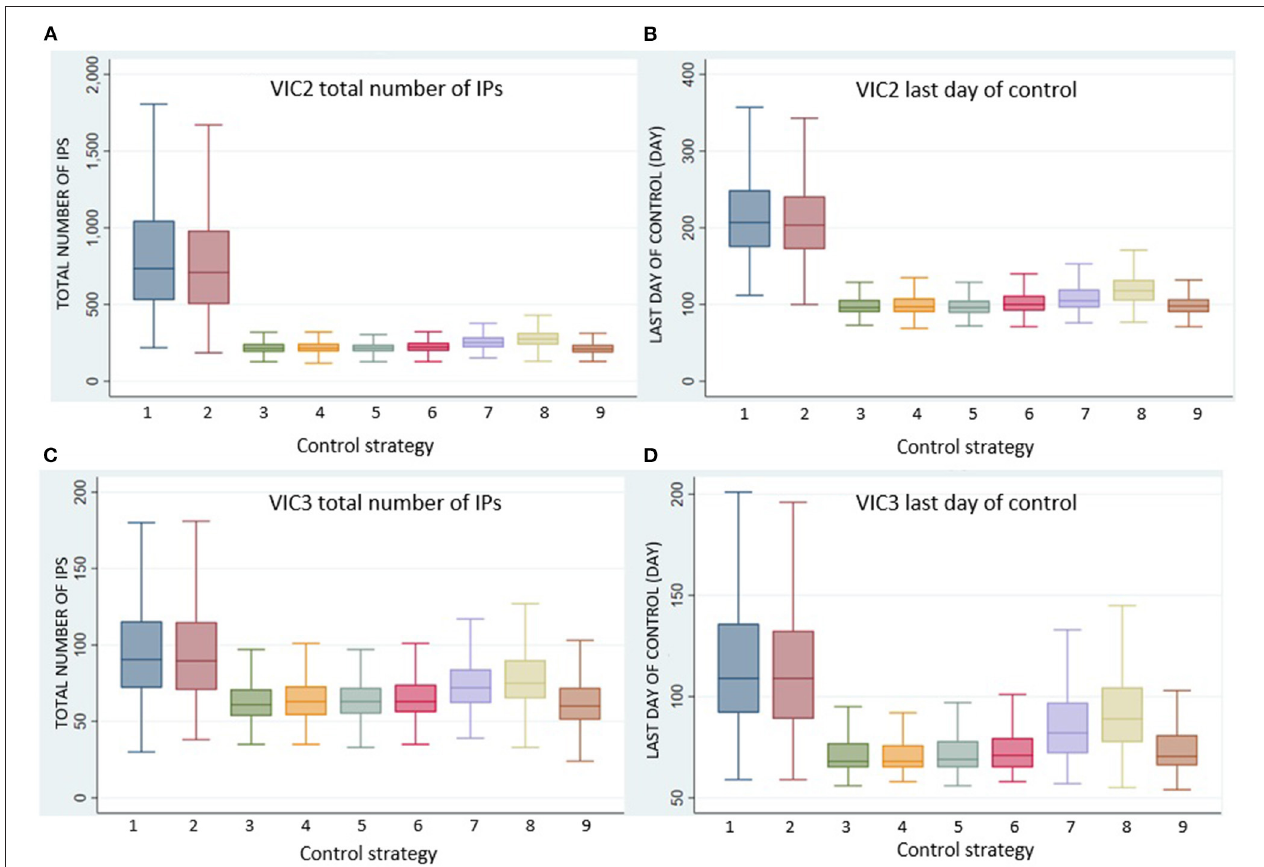
FIGURE 3 | Boxplots of (A) VIC2 total number of IPs, (B) VIC2 last day of control, (C) VIC3 total number of IPs, and (D) VIC3 last day of control for each control strategy, Control Strategy 1 to Control Strategy